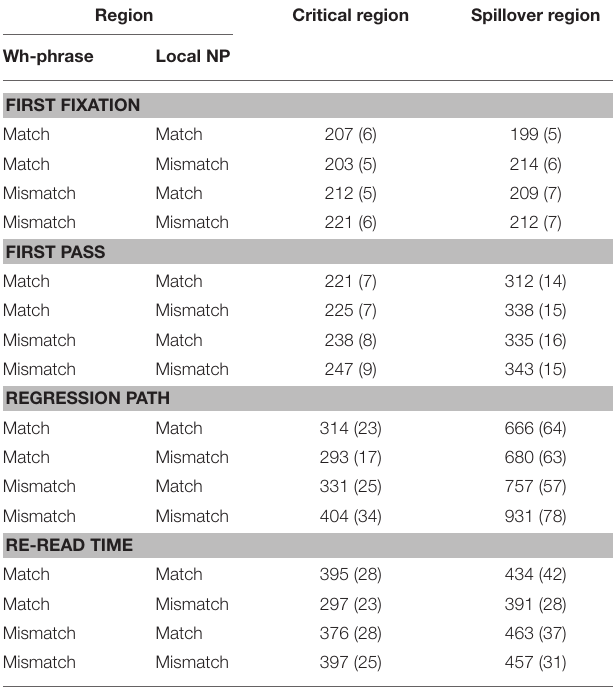
TABLE 1 | Means (and Standard Errors) for Experiment